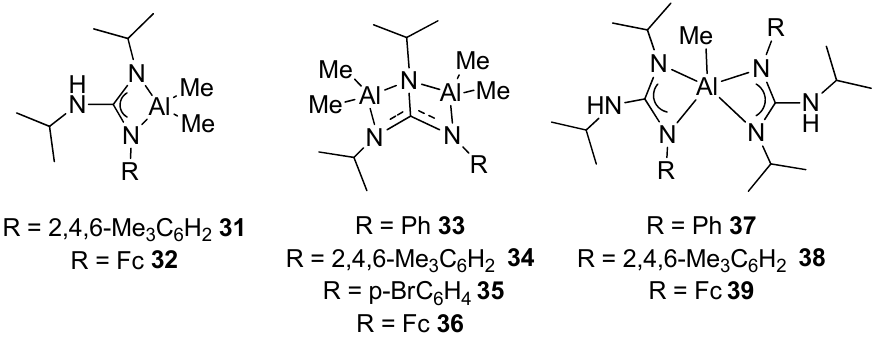
Figure 23. Mononuclear and dinuclear aluminum compounds with different coordination numbers.